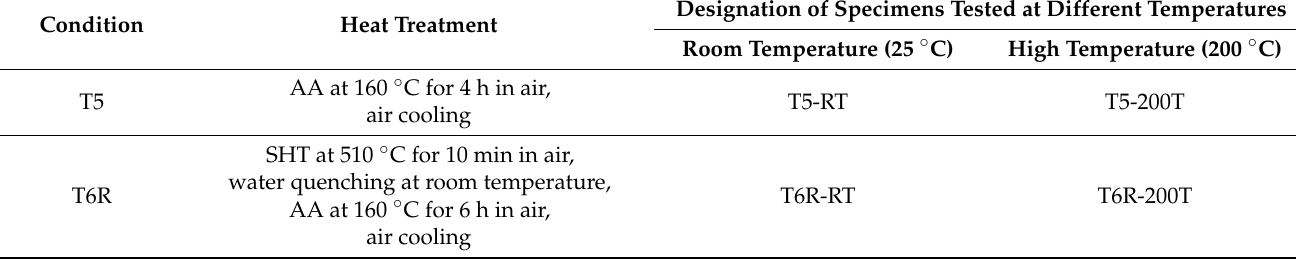
Table 2. L-PBF AlSi10Mg alloy heat treatment